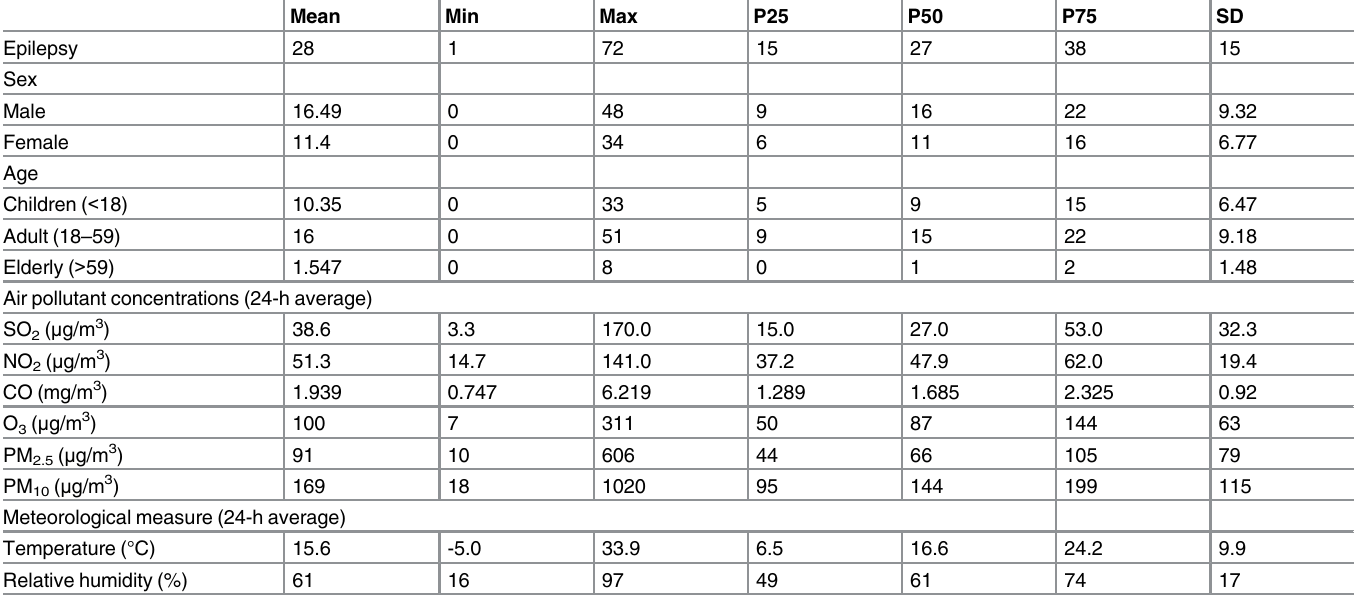
Table 1. Descriptive statistics for daily morbidity, concentrations of air pollutants, and weather conditions.